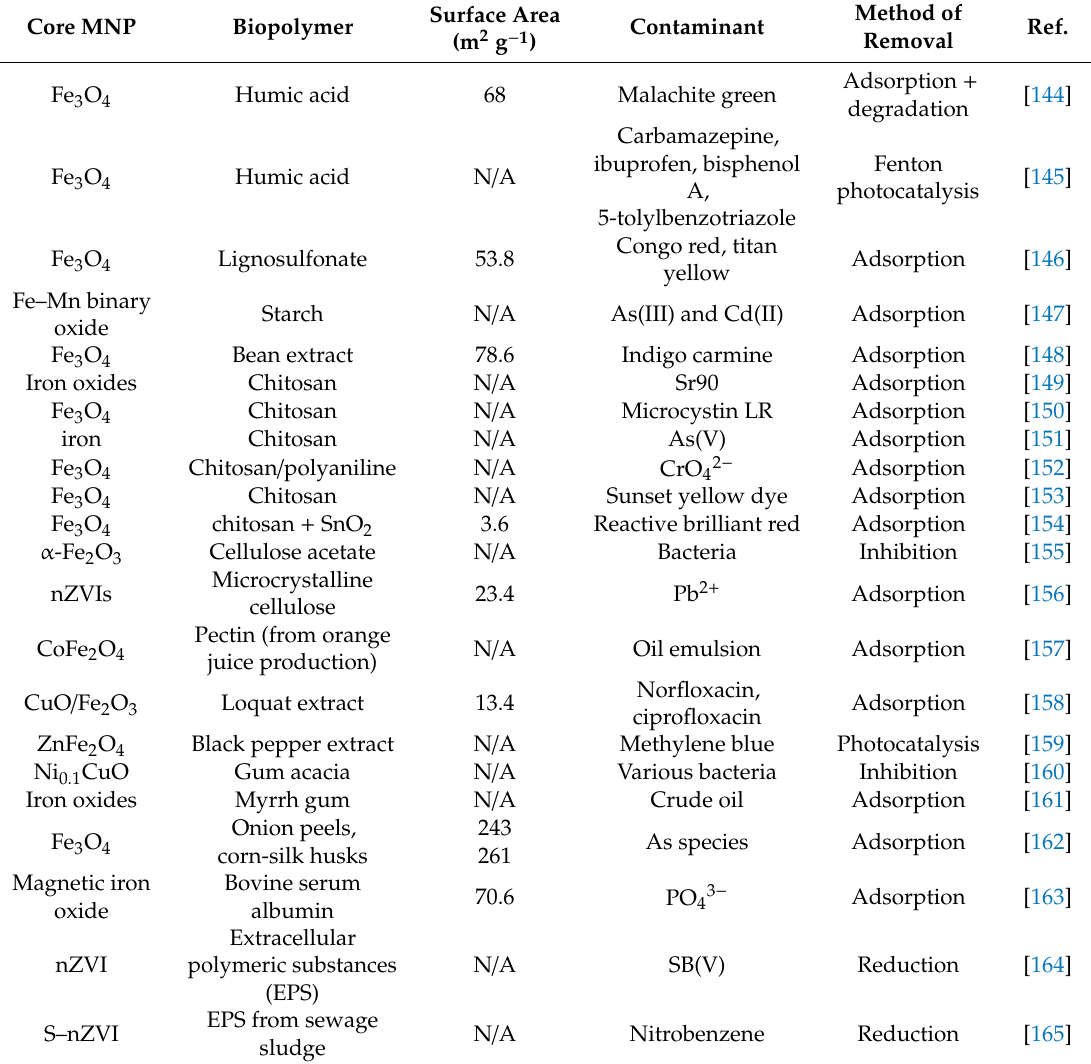
Table 8. Magnetic nanocomposites with biological polymers and